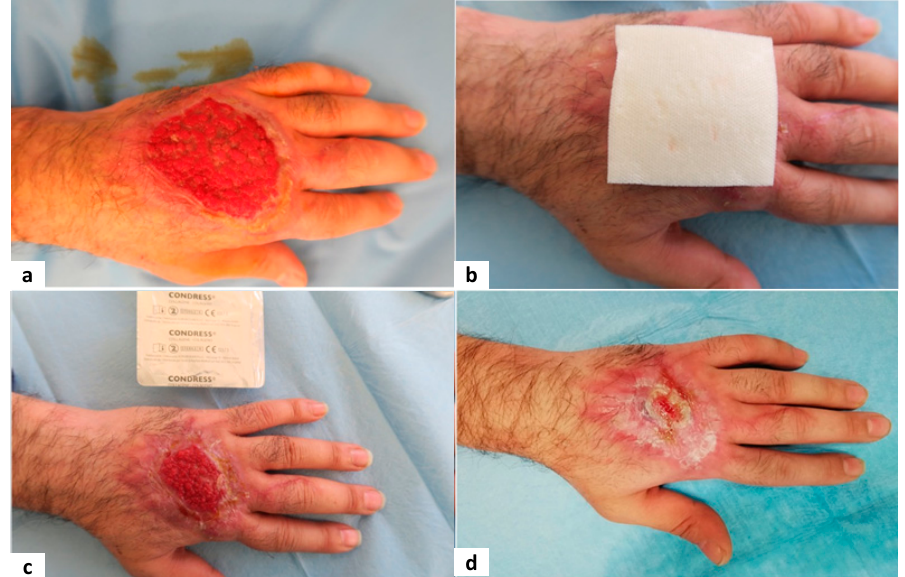
Figure 5. Case Group C. MT male 59 y/o affected by dyslipidemia, diabetes and hypertension reported a post traumatic chronic wound in the dorsal aspect of the left hand. The aspect of the wound 12 weeks after trauma ( a ). Application in V1 of the collagen plate ( b ). Wound appearance at V3 ( c ) and final aspect with almost complete re-epithelialization in V4 ( d